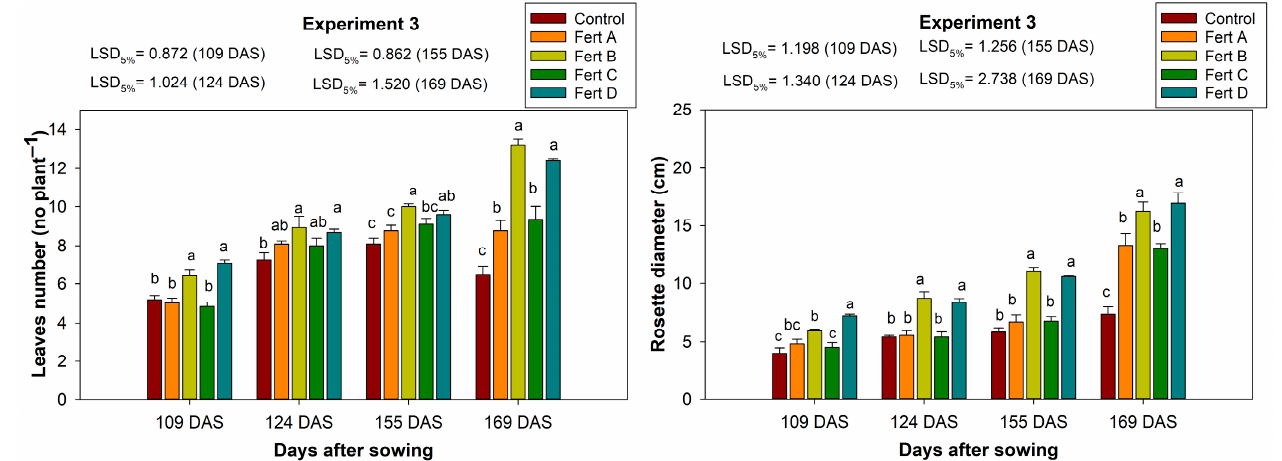
Figure 10. Leaf number (no plant − 1 ) and rosette diameter (cm) of bristly oxtongue as affected by various fertilization regimes. For each sampling date, bars followed by the same letters were not shown to significantly differ with Fisher’s least significant difference (LSD) test. The error bars show the Standard Error values. Final measurement (source of variation: treatments): Leaf number: Fvalue = 34.642, p <0.001, DF (degrees of freedom) = 4 and Rosette diameter: Fvalue = 20.279, p < 0.001, DF = 4.